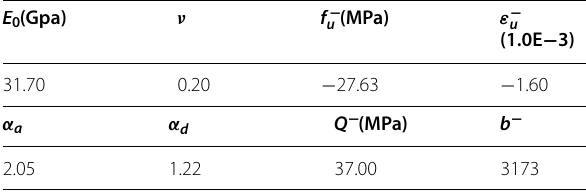
Table 3 Material properties used for the monotonic uniaxial compressive test.